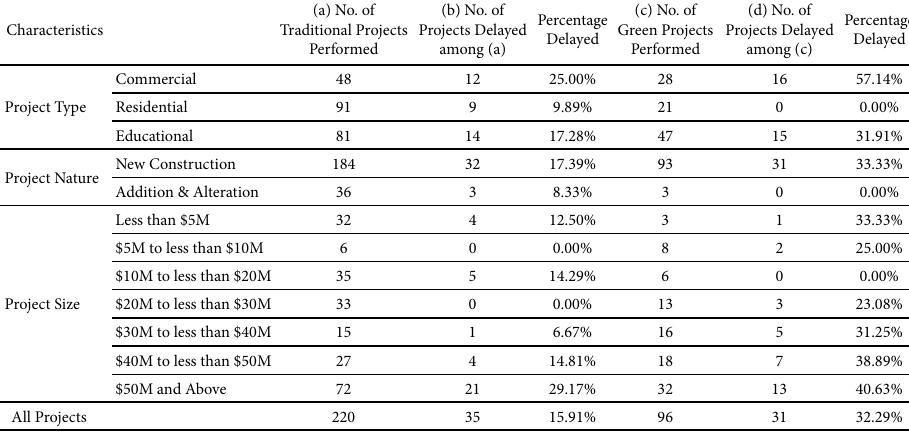
Table 3. Project delay: traditional vs. green building projects